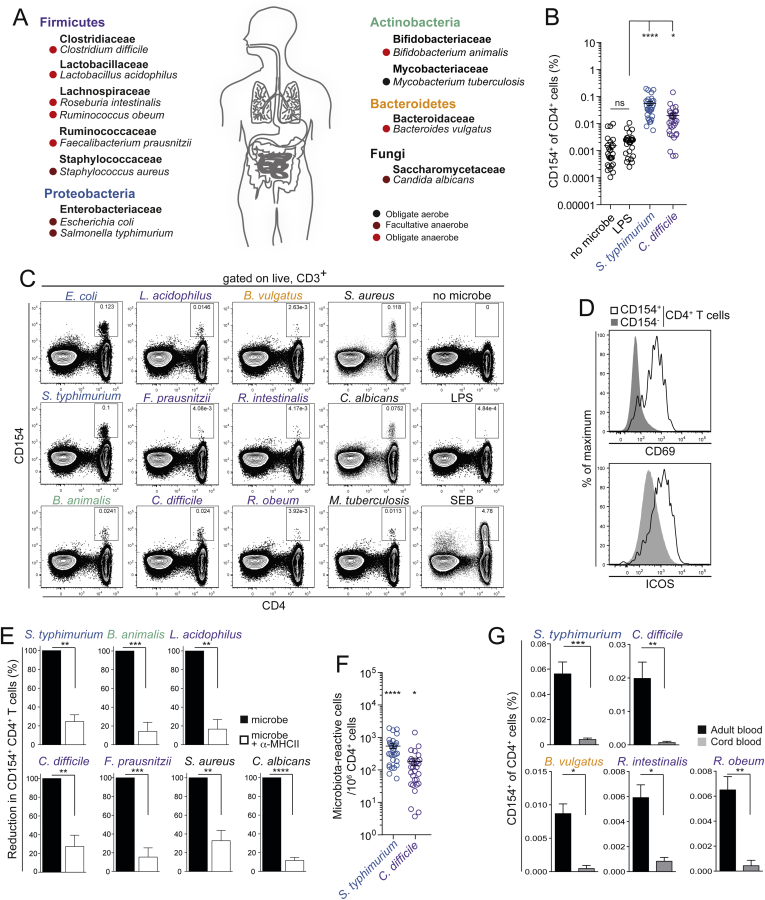
Bacterial strains used in the study and detection of enteric bacteria-specific memory CD4+ T cells (related to Figure 1). (A) Bacterial species are listed according to their family and phylum classification. Colored circles relate the bacteria to their gaseous requirement. (B) Frequencies of CD154+ cells among peripheral CD4+ T cells in adults after short-term stimulation with heat-inactivated bacteria. Dots represent different donors (n = 30). (C) Representative flow cytometric plots of different stimulations showing CD154 expression against CD4 within CD3+ cells after short-term stimulation with heat-inactivated bacteria. Frequencies of CD154 within CD4+ T cells are depicted. (D) Representative plot of CD69 and ICOS expression on CD4+CD154+ T cells after short-term stimulation with heat-inactivated S typhimurium. (E) PBMCs were stimulated with the indicated heat-inactivated bacteria in presence or absence of major histocompatibility complex II (MHCII) blocking antibodies and analyzed for CD154 expression. Percentage of reduction in CD154+ frequencies after MHCII blockade compared to control treated is depicted. Frequencies (±SEM) of 3 independent experiments are depicted (n = 5−6 independent donors). (F) Estimated microbiota-reactive cells per million CD4+ T cells in adult blood (n = 30). The numbers of microbiota-reactive T cells were calculated based on the frequencies of CD4+CD154+ T cells. Background (no microbe stimulation) was subtracted from bacterial stimulations. Significance calculated in relation to lipopolysaccharide (LPS) stimulation. (G) Frequencies ± SEM of CD154+ cells among CD4+ T cells in adult (n = 30) or cord blood (n = 3) after short-term stimulation with heat-inactivated bacteria. Statistics: (E, G) Mann-Whitney test; (C, F) 1-way analysis of variance with Sidak’s multiple comparison test; ns, not significant; ∗P ≤ .05; ∗∗∗P ≤ .01; ∗∗∗P ≤ .001; ∗∗∗∗P ≤ .0001.